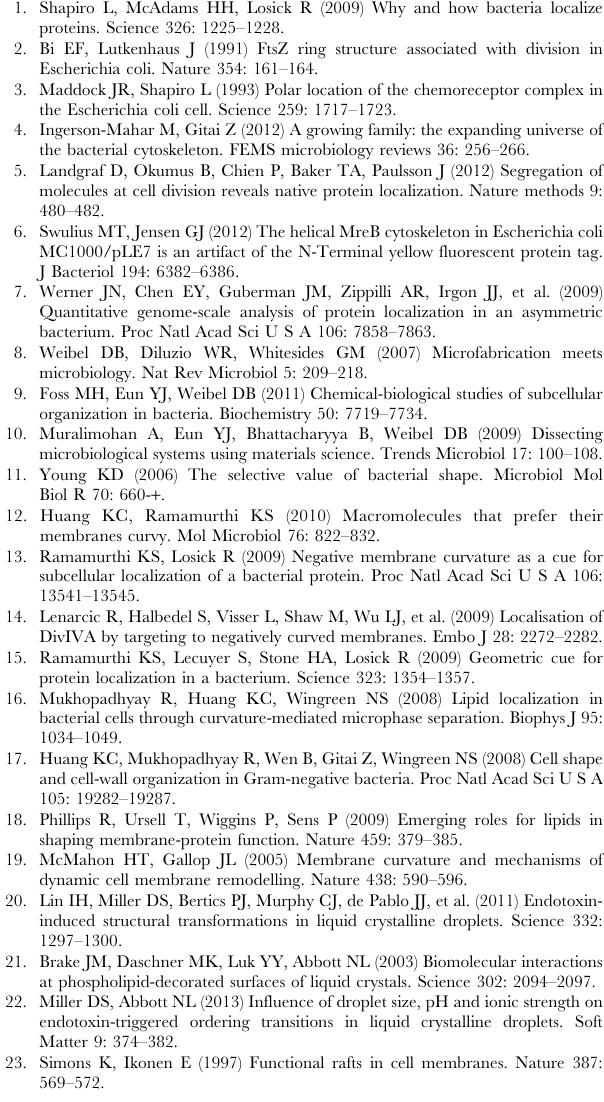
diagram using Origin (Origin Lab). We analyzed up to 40 cells per curvature region and plotted the average distance versus the curvature of the different angular microchannels. Figure S4 Analysis of DivIVA distribution in angular microchambers of filamented E. coli pKR179 and pKR196. E. coli pKR179 expresses DivIVA from the ectopic locus at basal levels. The induction levels of DivIVA in E. coli pKR196 can be adjusted with different levels of IPTG via a hyperspank promotor. The images are representative bright field and fluorescence images of filamented E. coli pKR179 and E. coli pKR196 with 1, 10 and 50 m M IPTG in angled microchambers.